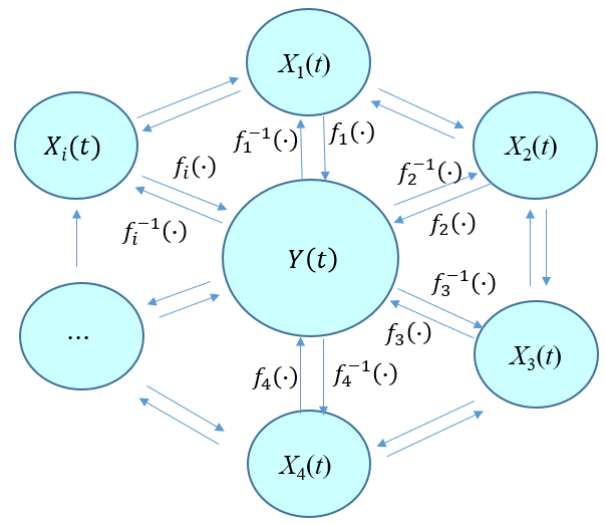
Figure 1. The relationship between hydrological variable Y and its influencing factors.